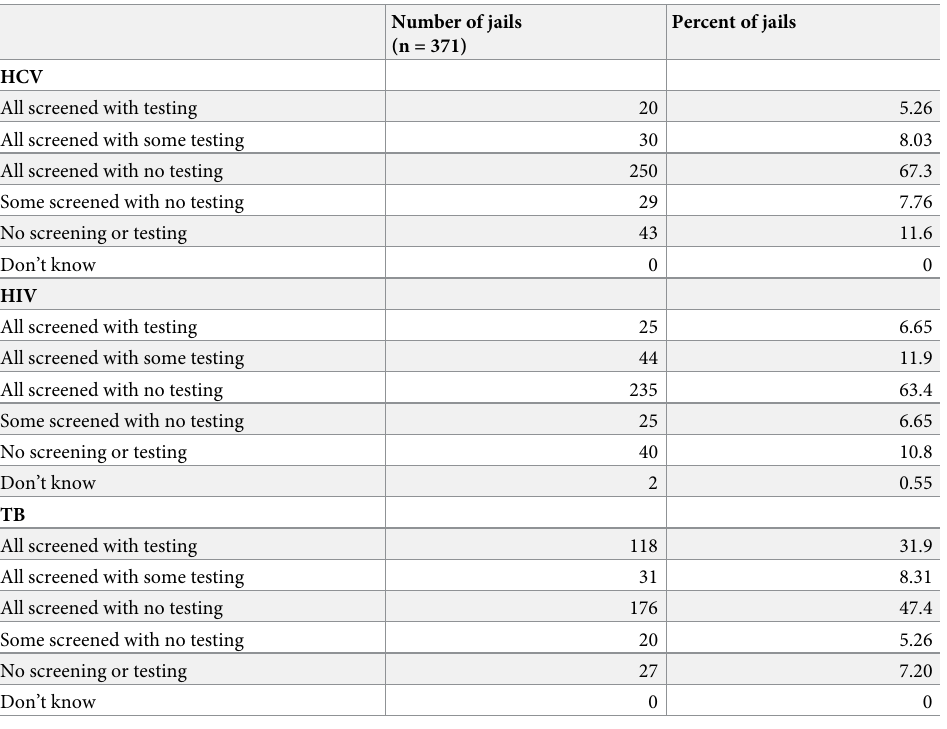
Table 1. HIV, TB, and HCV surveillance procedures at